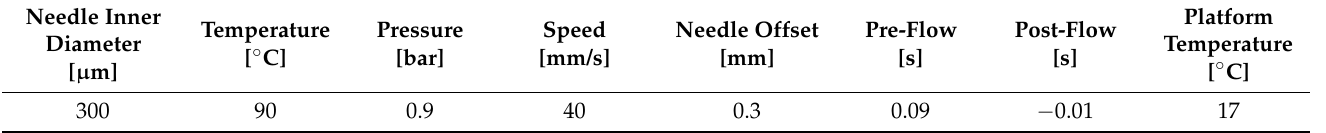
Table 1. General parameters for 3D